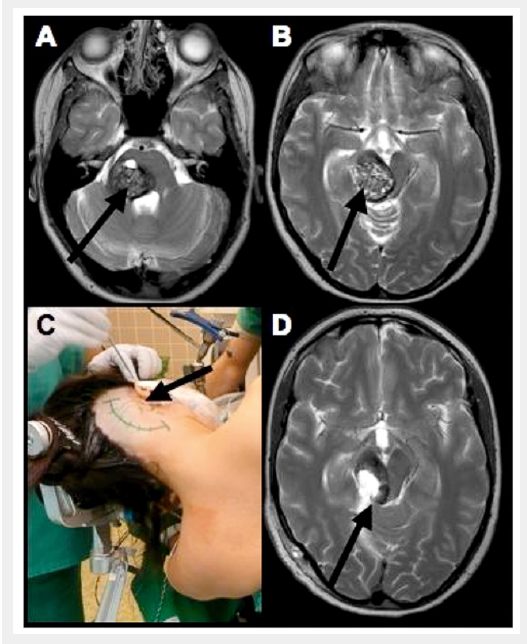
Figure 1 A 25 yo/f suffering from a right pontomesencephalic cavernomal haemorrhage (arrows) with subacute ataxia, hemiparesis and facial palsy (A and B). The surgery was performed on the left side via a combined supracerebellar and retrosigmoid approach (C). The arrows represent the approach to the cavernoma. Postoperative MRI image in T2 (D) revealed complete resection of the cavernoma with residual haemosiderin from the haemorrhages in the intact brainstem tissue (arrow). Postoperatively, only a temporary slight increase of ataxia was noted and further follow-up showed almost complete resolution of the preoperative